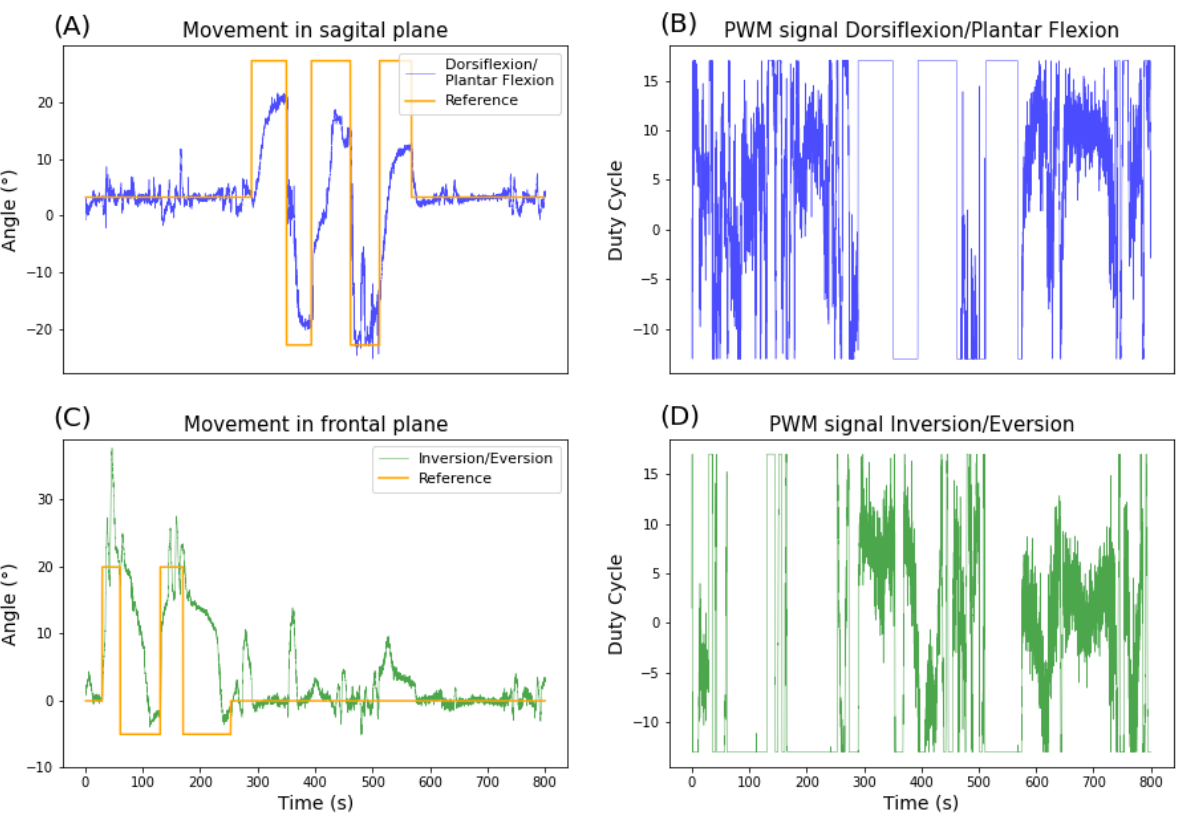
Figure 8. Closed-loop ankle joint control. ( A ) The position of the ankle joint (in degrees) in relation to the reference in sagital plane. ( B ) PWM signal for stimulation of stimulation channels to produce dorsiflexion and plantar flexion movements. ( C ) The position of the ankle joint (in degrees) in relation to the reference in frontal plane. ( D ) PWM signal for stimulation of stimulation channels to produce inversion and eversion